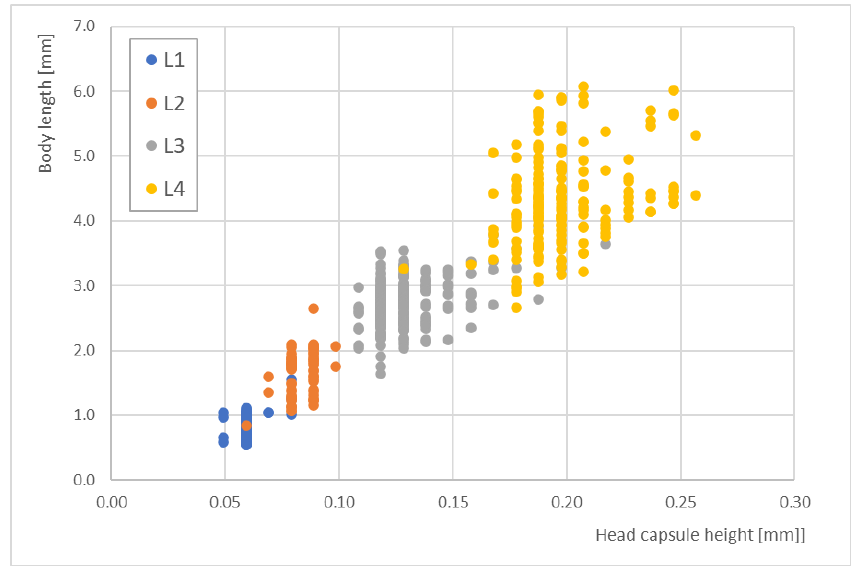
Figure 5. The correlations between head capsule height and total body length for the four larval stages (L1 to L4) of Paratanytarsus grimmii ( n = 565).